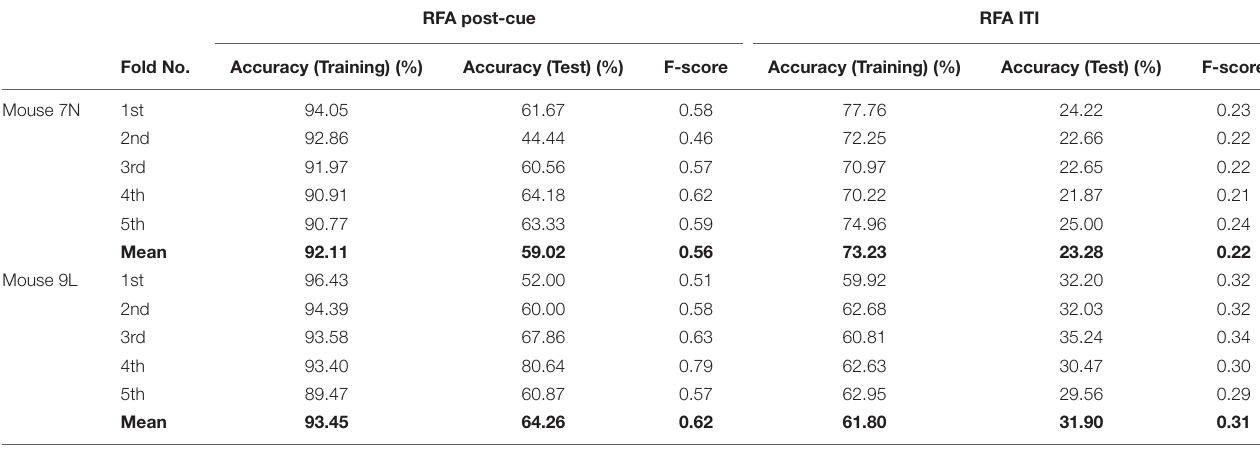
Bold values indicate data group names, performance matrices and mean results of five-fold cross validation. TABLE 2 | Five-fold cross validation results of maximum reach location prediction of ITI group for mice 7N and 9L with epoch number equals to 600. Fold No.